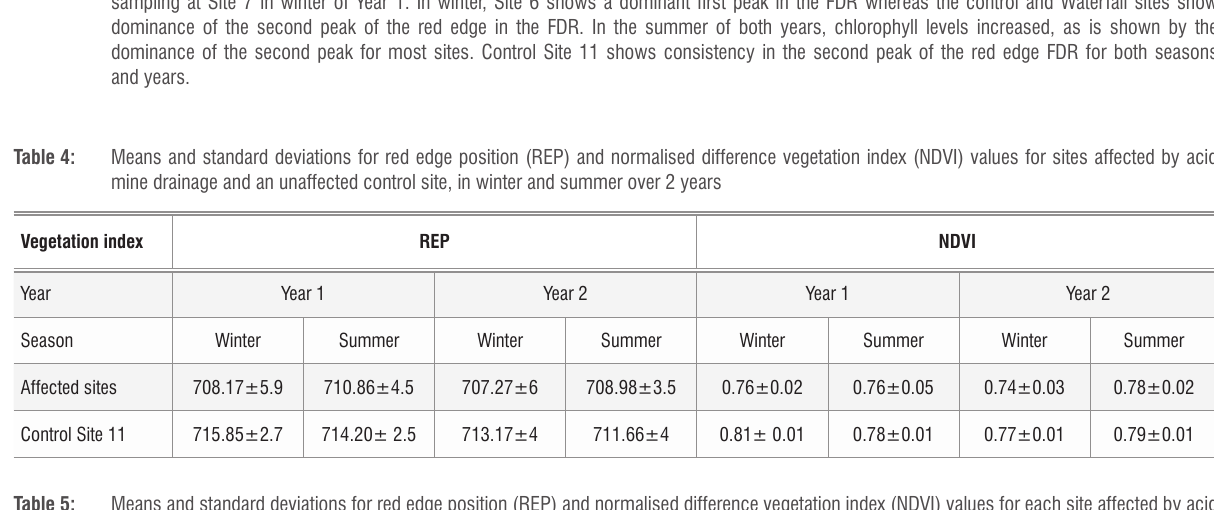
Means and standard deviations for red edge position (REP) and normalised difference vegetation index (NDVI) values for each site affected by acid mine drainage and an unaffected control site, in winter and summer over 2 years Vegetation